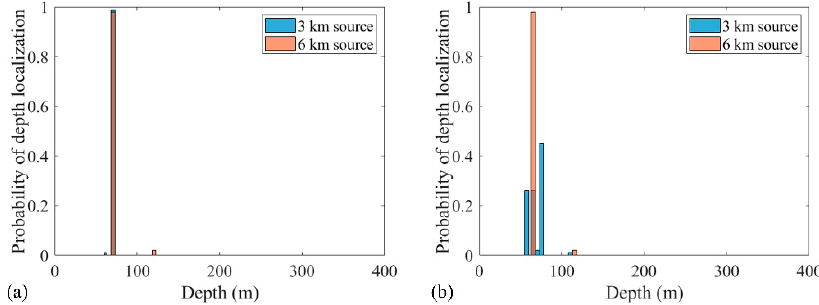
Figure 10. (a) The measured and mismatched SSPs are represented as the red line and blue line, respectively; ( b ) the ambiguity surfaces calculated by a Bartlett processor and the RAMPMF method using the measured SSP; ( c ) the ambiguity surfaces calculated by a Bartlett processor and the RAMPMF method using the mismatched SSP.